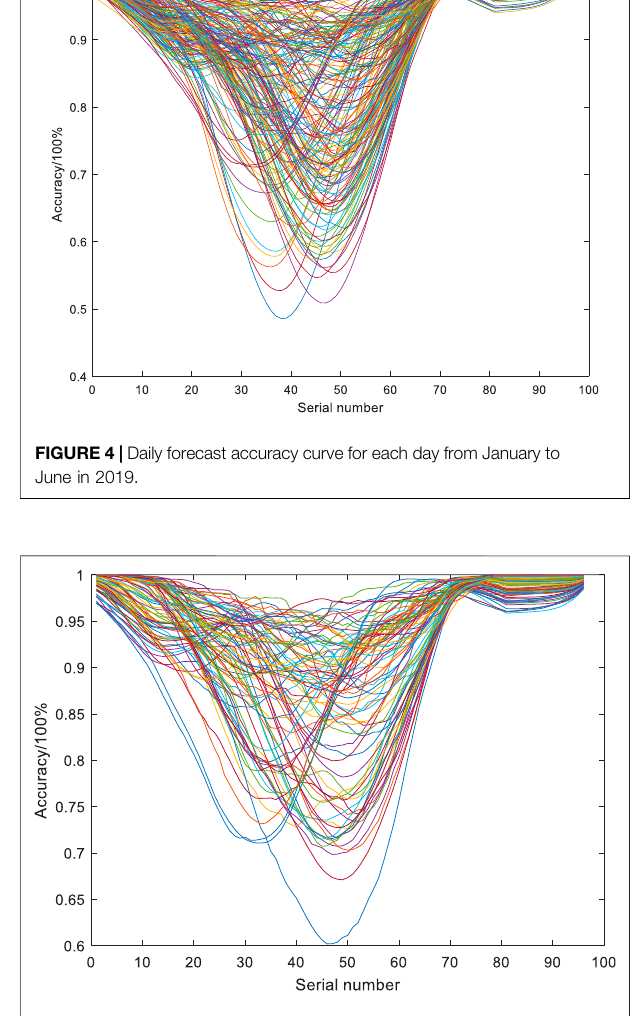
FIGURE 5 | Daily forecast accuracy from April to